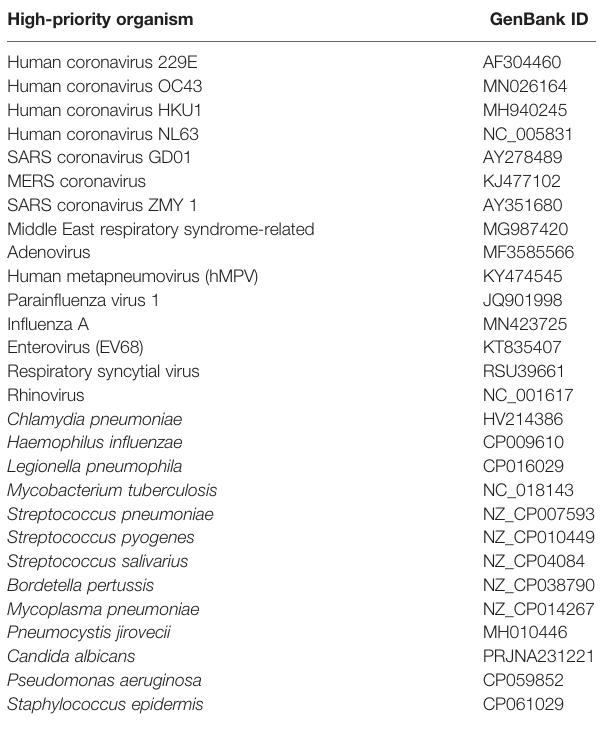
TABLE 1 | High-priority pathogens and coronaviruses closely related to SARS-CoV-2 used in the alignment with the fi nal LAMP primer sets. High-priority